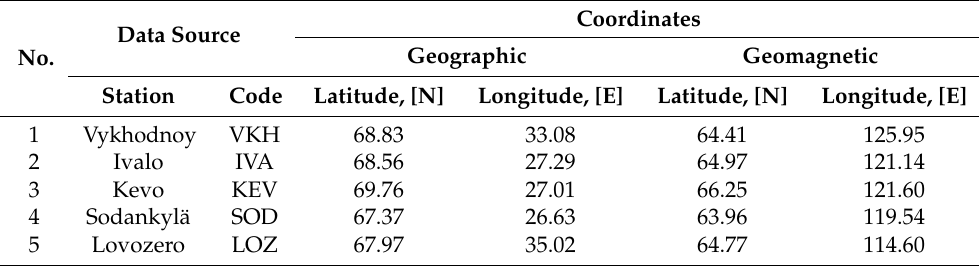
Figure 1. Geography of data sources: magnetometers (green circles) and GIC recording station (red circle). Black solid lines denote the 330/440 kV power lines. Table 1. Coordinates of the GIC recording station VKH and selected IMAGE magnetometers.